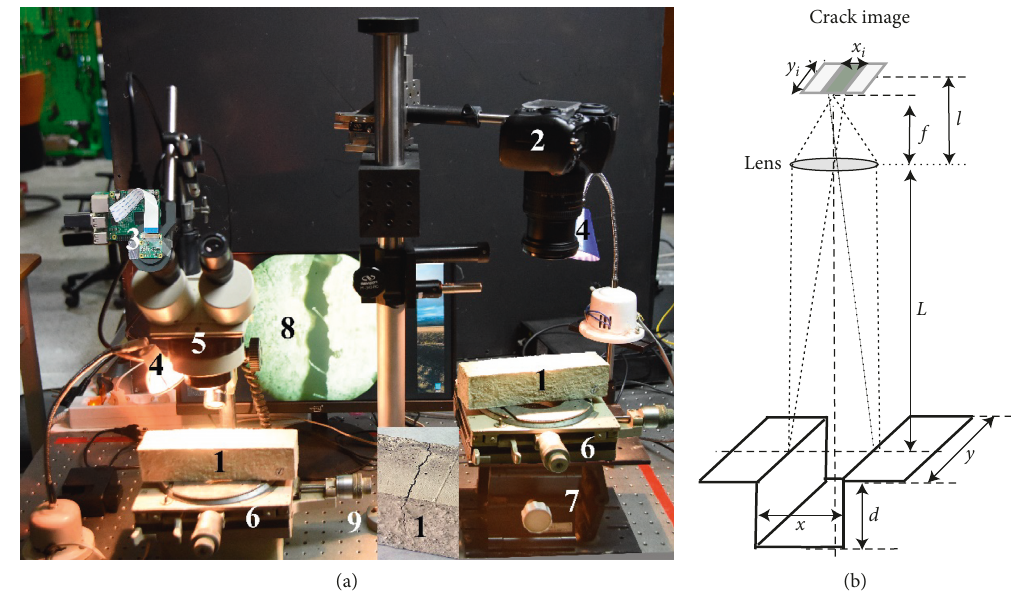
Figure 1: (a) Two experimental setups: 1: experimental sample with cracks; 2: Nikon Camera D810; 3: Raspberry Pi camera; 4: halogen lamps; 5: a binocular microscope; 6: 360 ° rotatable stage; 7: height control stage; 8: a monitor; 9: optical table. (b) Equivalent optical scheme of the experimental setups.